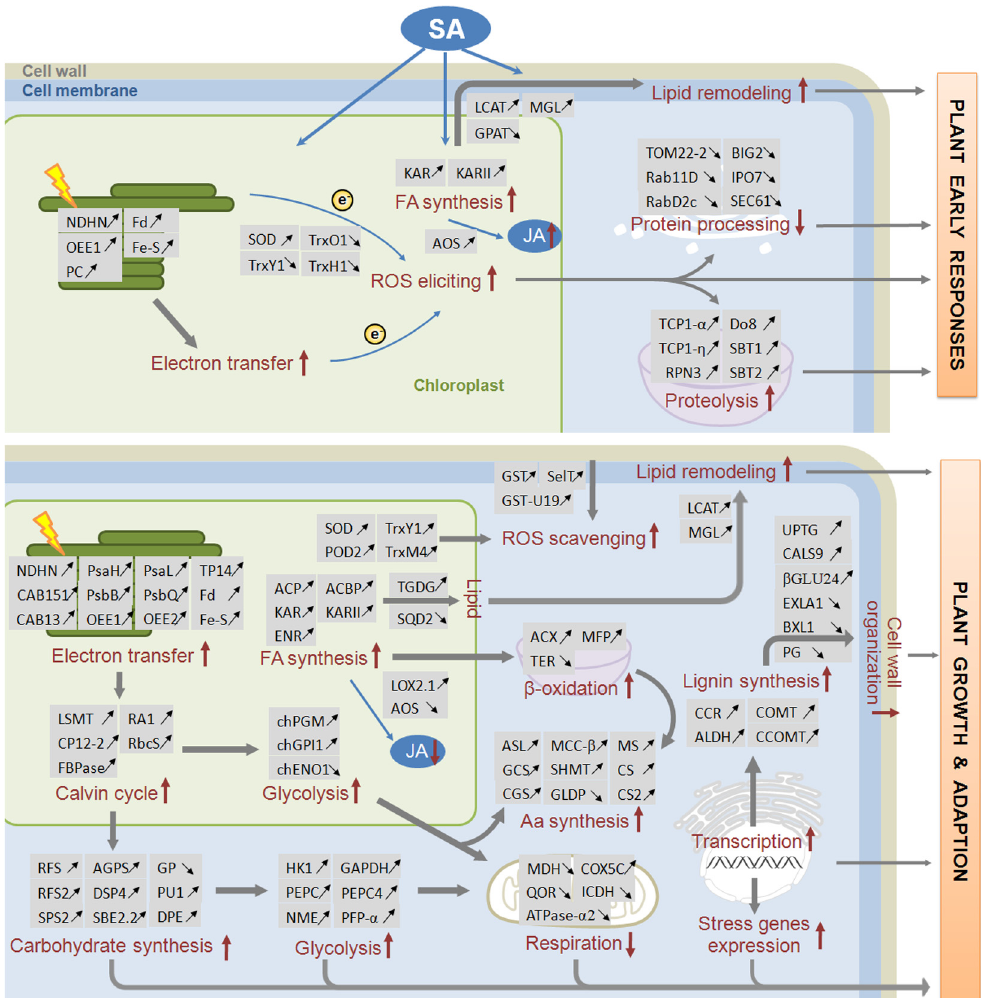
Fig 5. A putative SA-responsive protein network in the leaves of cucumber seedlings. Up- and down- regulation are marked as up and down arrows, respectively. Detailed descriptions are given in the text, and the full name for each abbreviation is available in S3 and S4